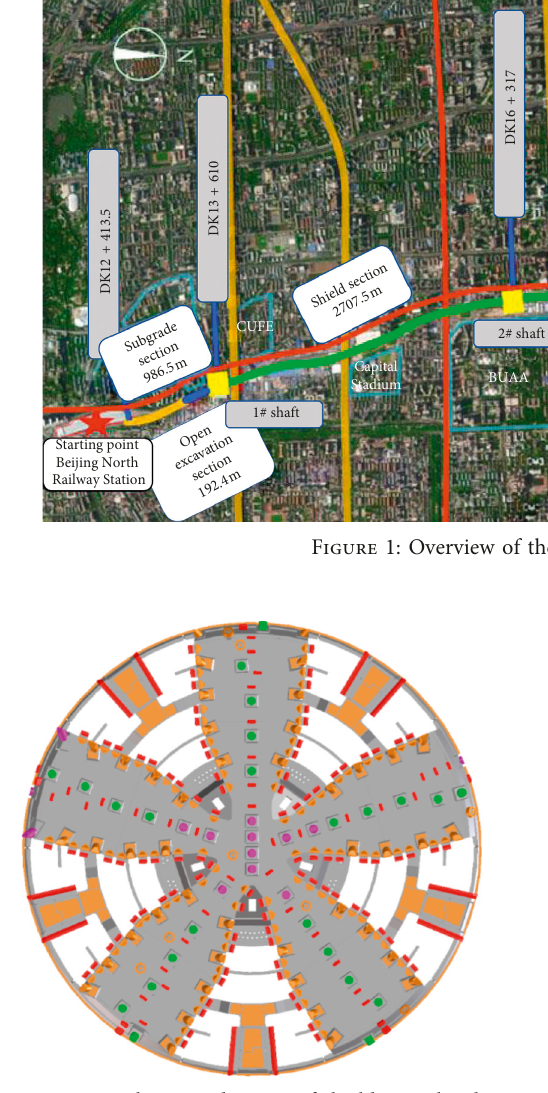
Figure 2: Schematic diagram of shield